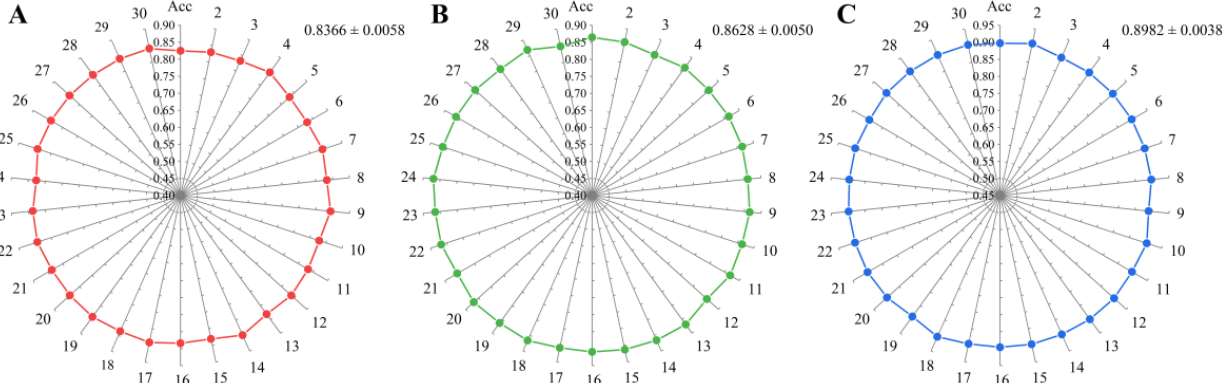
Table 10. Performance of CircPCBL on human